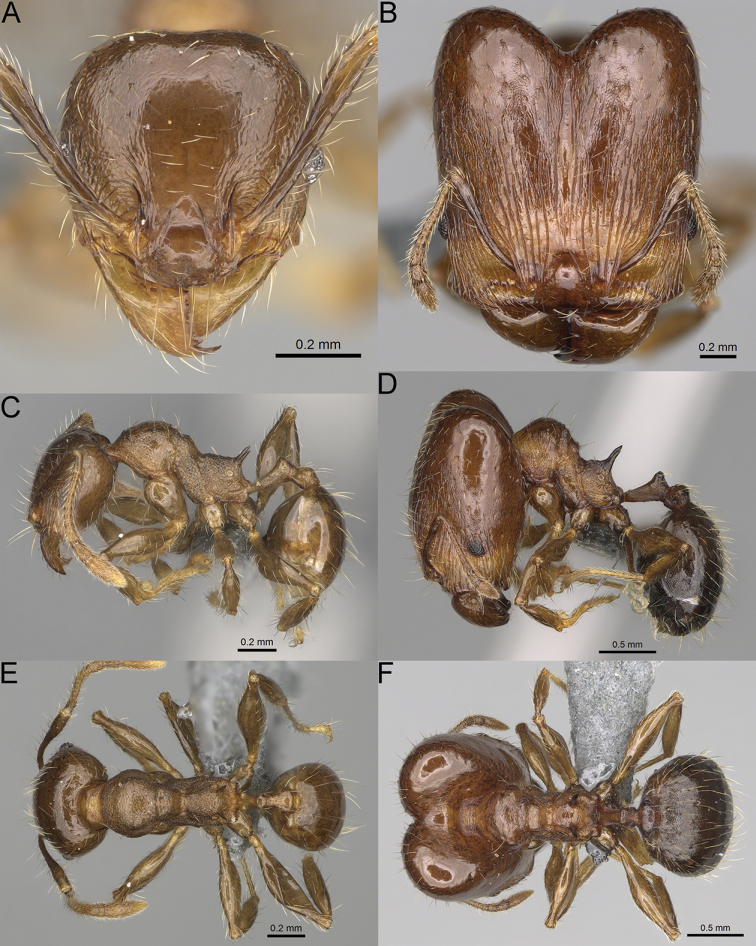
Pheidole
ensifera Forel, full-face view (A), profile (C), and dorsal view (E) of minor worker (CASENT0298364) and full-face view (B), profile (D), and dorsal view (F) of major worker (CASENT0923226).